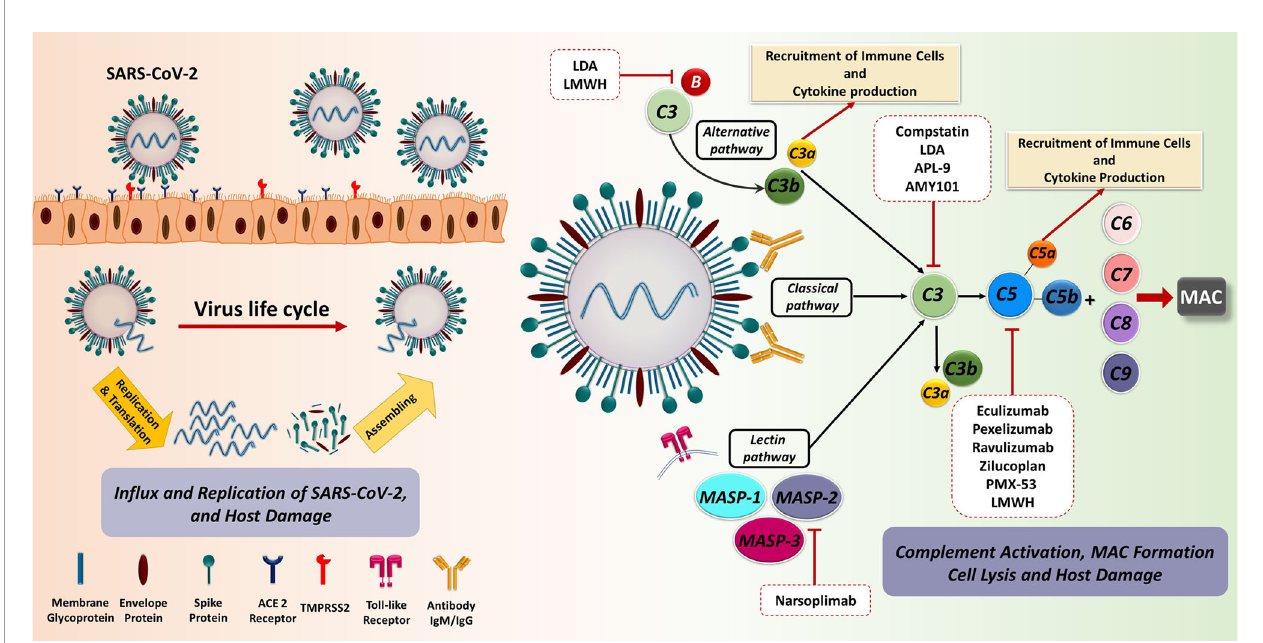
FIGURE 2 | The recognition and binding of S protein to the ACE2 receptor are fundamental key events in SARS-CoV-2 invasion of the host cells. The engagement of ACE2 receptor and S protein of SARS-CoV-2 induces the fusion of virus and target cell. This process is orchestrated by the cleavage of S protein into S1 and S2 subunits via transmembrane serine protease priming known as TMPRSS. Subsequently, prompt viral replication occurs inside the infected cell, contributing to the dissemination of infection. The C as a fi rst line of innate immune defence could recognize the virus. SARS-CoV-2 is capable of directly activating the C through the classical, alternative, and especially lectin pathways. Dysregulated C activation during the SARS-CoV-2 infection can cause serious damage to different organs. The blockade of C effectors has a potential therapeutic effect through the prevention of the recruitment of immune cell as well as immune activation. ACE2, Angiotensin-converting enzyme 2; LDA, Low-dose aspirin; LMWH, Low-molecular weight heparin; MAC, Membrane attack complex; MASP, MBL (mannose binding lectin) associated serine protease; SARS-CoV-2, Severe acute respiratory syndrome coronavirus 2; TMPRSS2, Transmembrane serine protease